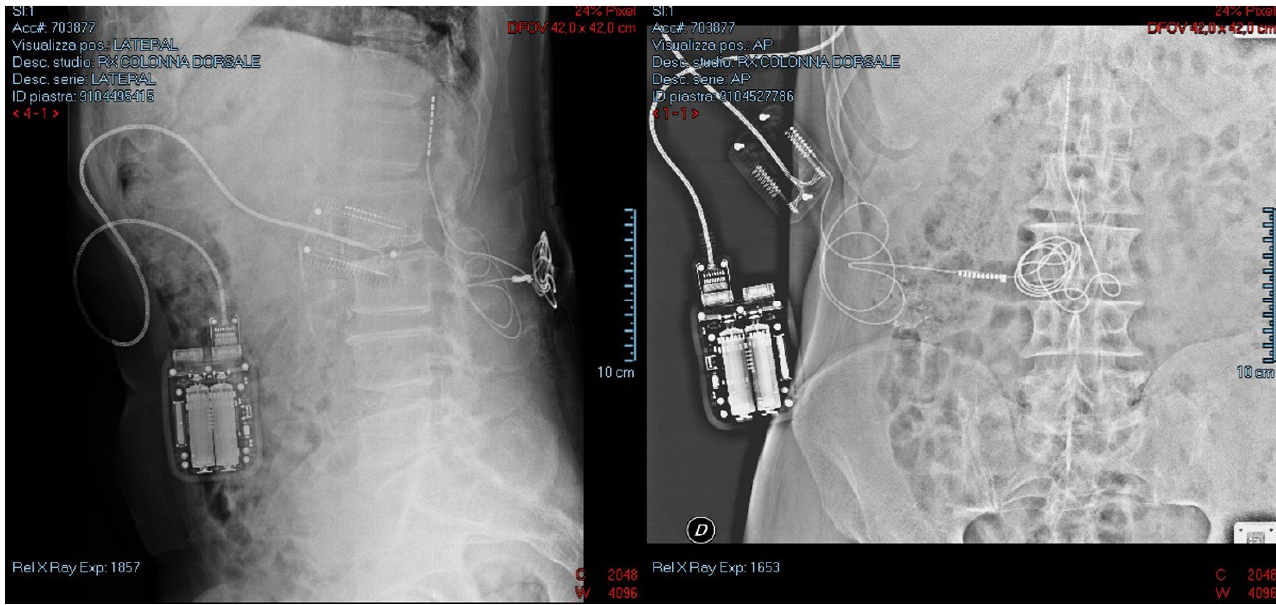
Figure 2. Anatomical position of the SCS.